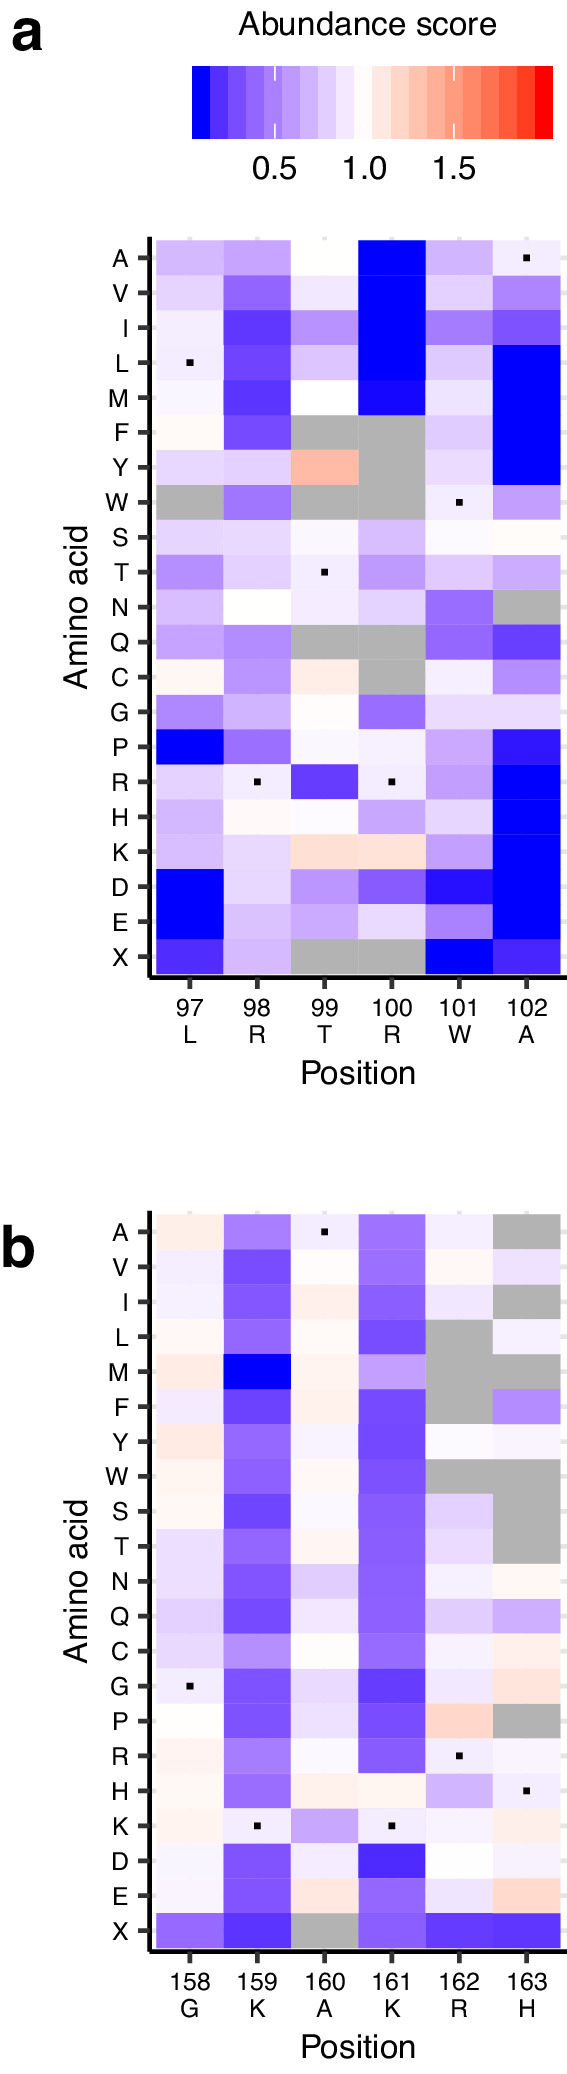
VKOR localization motif analysis.(a) Heatmap of abundance scores for diarginine ER retention motif. X-axis shows residues and position. Color indicates abundance scores scaled as a gradient between the lowest 10% of abundance scores (blue), the WT abundance score (white) and abundance scores above WT (red). Grey indicates missing data. (b) Heatmap of abundance score for dilysine ER retention motif. X-axis shows residues and position.